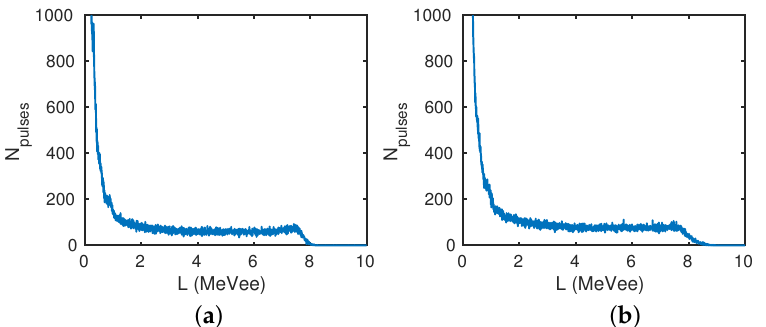
Figure 2. The number of pulses detected as a function of the equivalent electron energy L : ( a ) Neu- trons from the DT reaction with an energy of E n = 14MeV detected using 1 inch PYR5/DIPN scintillator. ( b ) Neutrons from the DT reaction with an energy of E n = 14MeV detected using 1 inch THIO5/DIPN